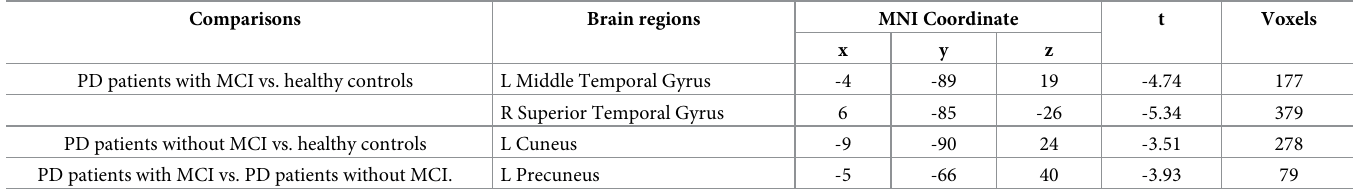
Table 3. Differences of cortical thickness between the groups by SBM analysis.